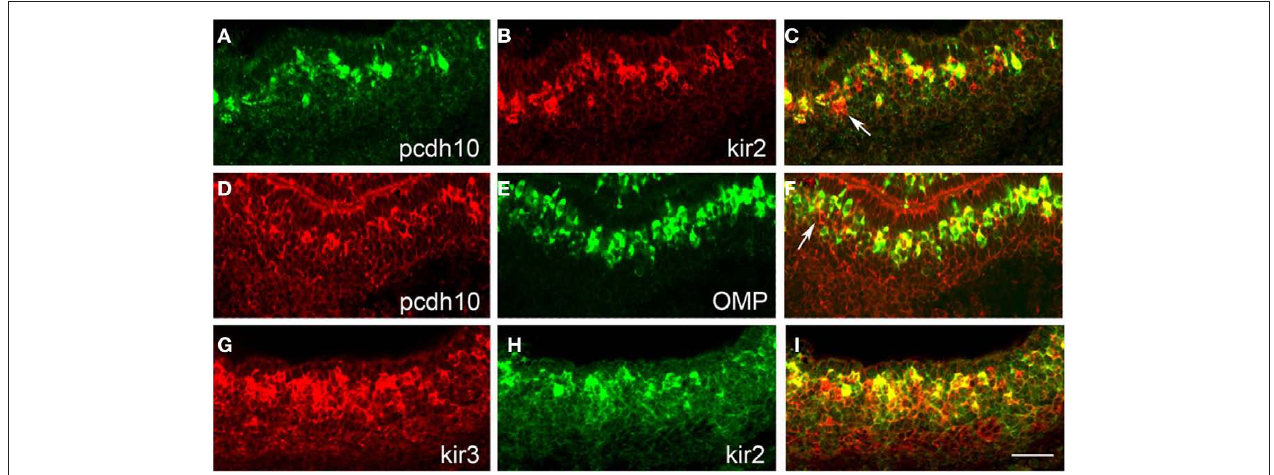
Figure 5 | Pcdh10 is co-expressed with kirrel2/kirrel3. (A–C) Double-label in situ hybridization with pcdh10 [ (A) ; green] and kirrel2 [ (B) ; red]. Not all kirrel2 -positive cells express pcdh10 [ (C) ; white arrow]. (D–F) Double-label in situ hybridization with pcdh10 [ (D) ; red] and OMP [ (e) ; green]. Pcdh10 is expressed